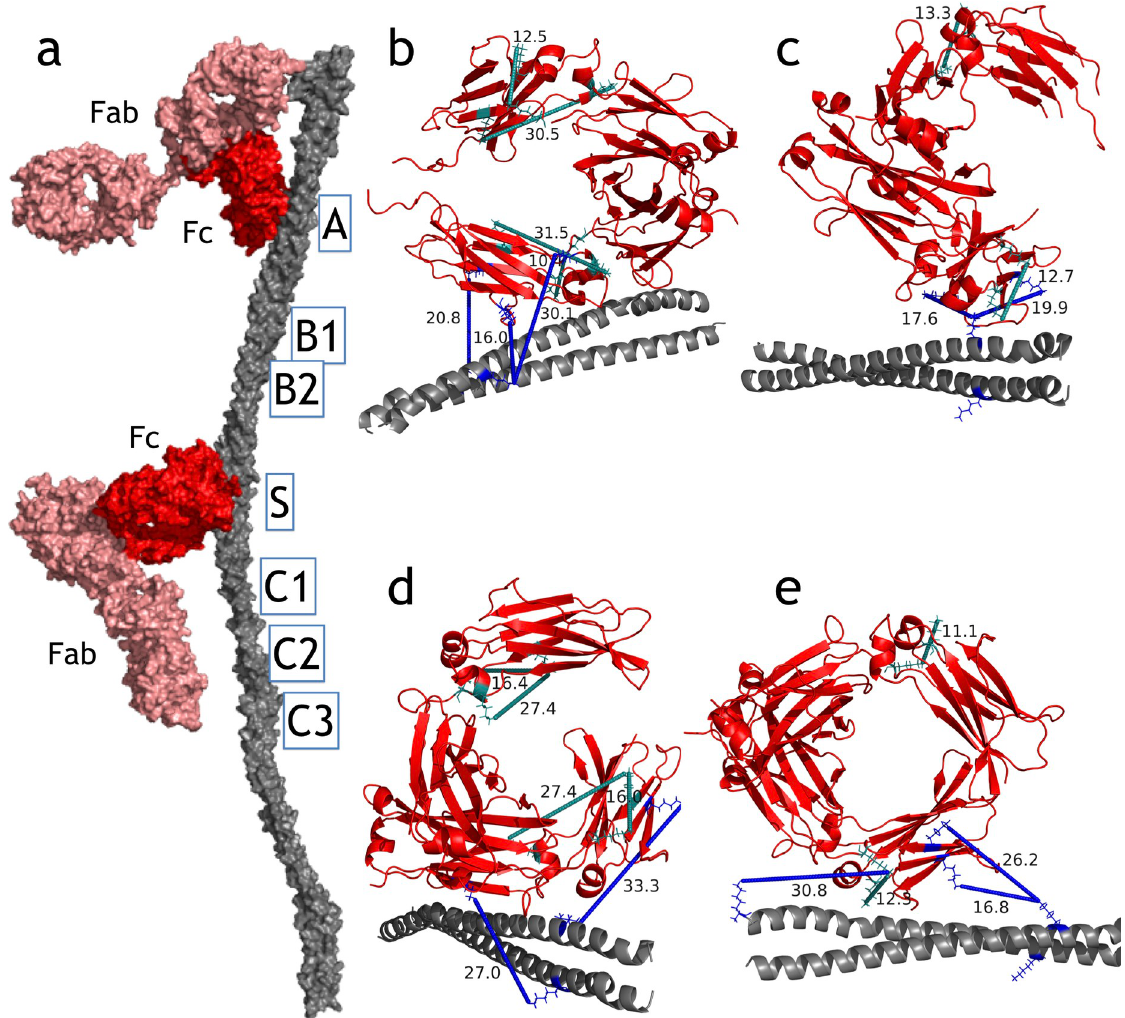
Fig 2. M1 interactions with IgG subclasses. (a) The model for M1 (A- and S-domains)-IgG1 full length non-immune Fc-mediated interaction. Important domains of the M1 protein are shown, where A- and S-domains play a crucial role. The molecular details of the Fc- binding site are shown in panel (b) where inter- and intra-XLs are mapped on the protein complex. (b-e) The S-domain of the M1-protein interacts with the Fc-region of IgG1-4. All models are generated by the TX-MS workflow based on cross-link constraints derived from MS data. Intra-XLs for each IgG are shown in cyan, while inter-XLs between the two proteins are in blue. The binding interfaces of the M1 protein on the Fc-domain of all IgG subclasses are similar and mediated via the CH3 domains. This region is involved in binding to IgG Fc- receptors (Fc γ R), predicted to be inhibited by the M1 protein